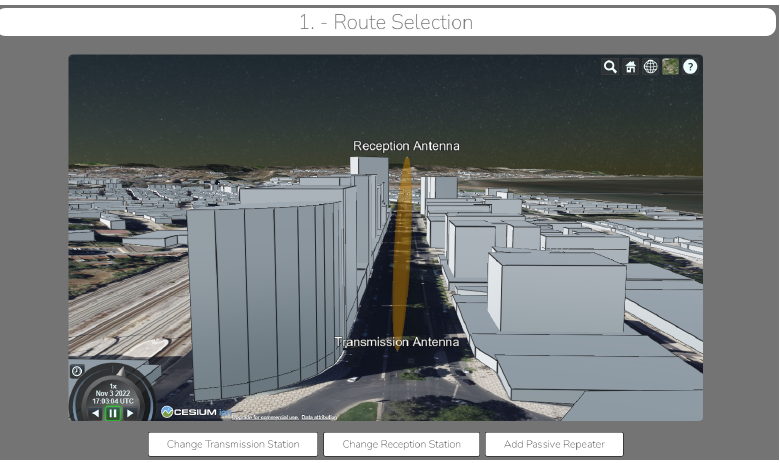
Figure 3. Path definition